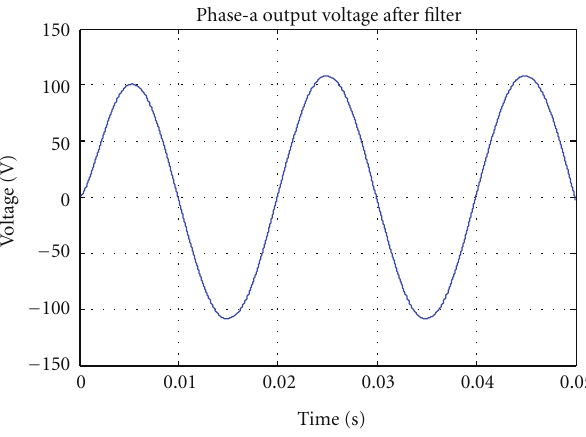
Figure 10: Inverter output phase voltage, v a , after the filter.